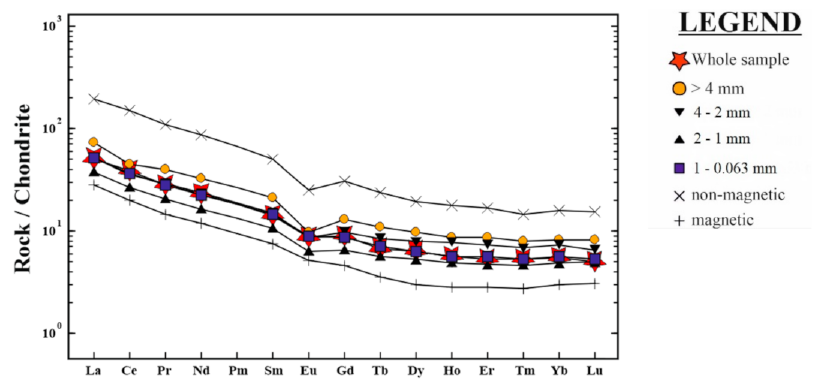
Figure 5. REE patterns of the separated fractions (Normalization after [27]).